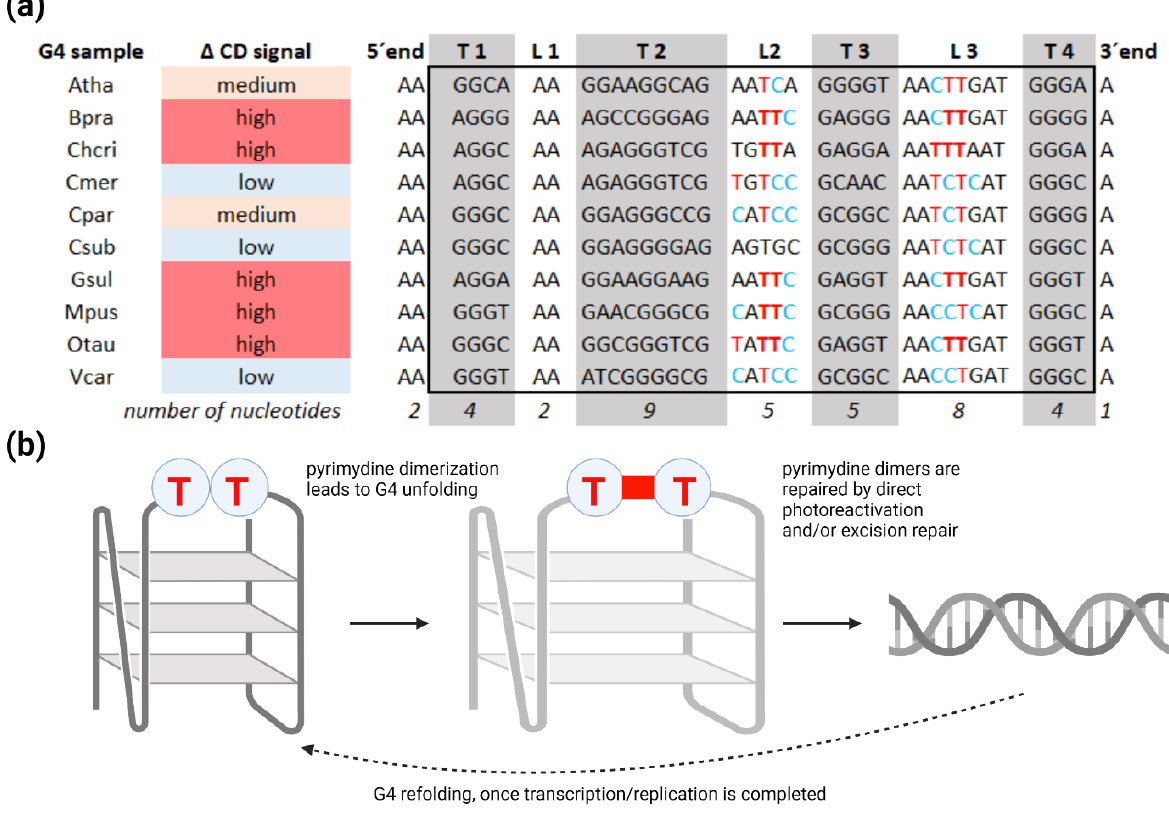
Figure 5. Plants G4s interacts with UVB/UVA light. ( a ) Decrease in molar ellipticity in UV-irradiated G4 samples expressed on the categorical scale (low, moderate, and high decrease). Guanine tracks are highlighted in grey color and designated T1–T4. Loop regions are designated L1–L3. Pyrimidines with the ability to form cyclobutane pyrimidine dimers are depicted in red (thymines) and blue (cytosines). Adjacent thymines with the highest probability to form thymine dimers are in bold. ( b ) Adjacent or opposite pyrimidines in the G4 loops can form cyclobutane pyrimidine dimers [22], which lead to conformational change and/or unfolding of G4 structure. Pyrimidine dimers are then repaired by photoreactivation and/or excision repair [60–62], and G4s can then reform via refolding. Concurrently, important molecular processes (DNA replication and transcription) can take place.